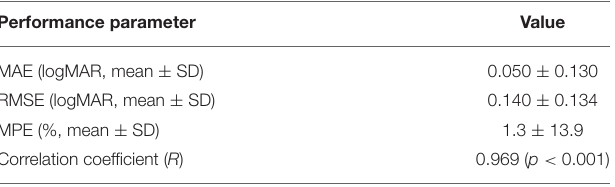
TABLE 2 | Performance of the artificial intelligence model for prediction of preoperative best corrected visual acuity in patients with senile cataract. Performance parameter